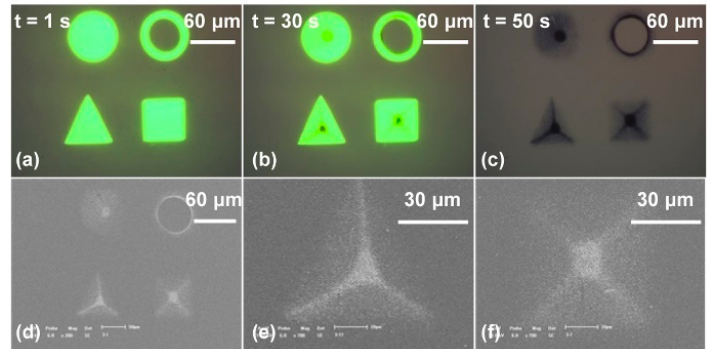
Figure 9. Rapid assembly of various microstructures using gold nanoparticles (AuNPs) with a diameter of 100 nm. ( a ) Four different optical patterns served as virtual electrodes, with an external AC bias potential switched on simultaneously; ( b ) after 30 s, the AuNPs were attracted into the areas illuminated by the four patterns; ( c ) AuNP-based microstructures formed when the optical patterns were moved and AC bias potential was switched off; ( d ) SEM images of ( c ); ( e ) SEM image of an AuNP-based microstructure in triangle pattern; ( f ) SEM image of an AuNP-based microstructure in square pattern (reproduced from Ref. [72]).